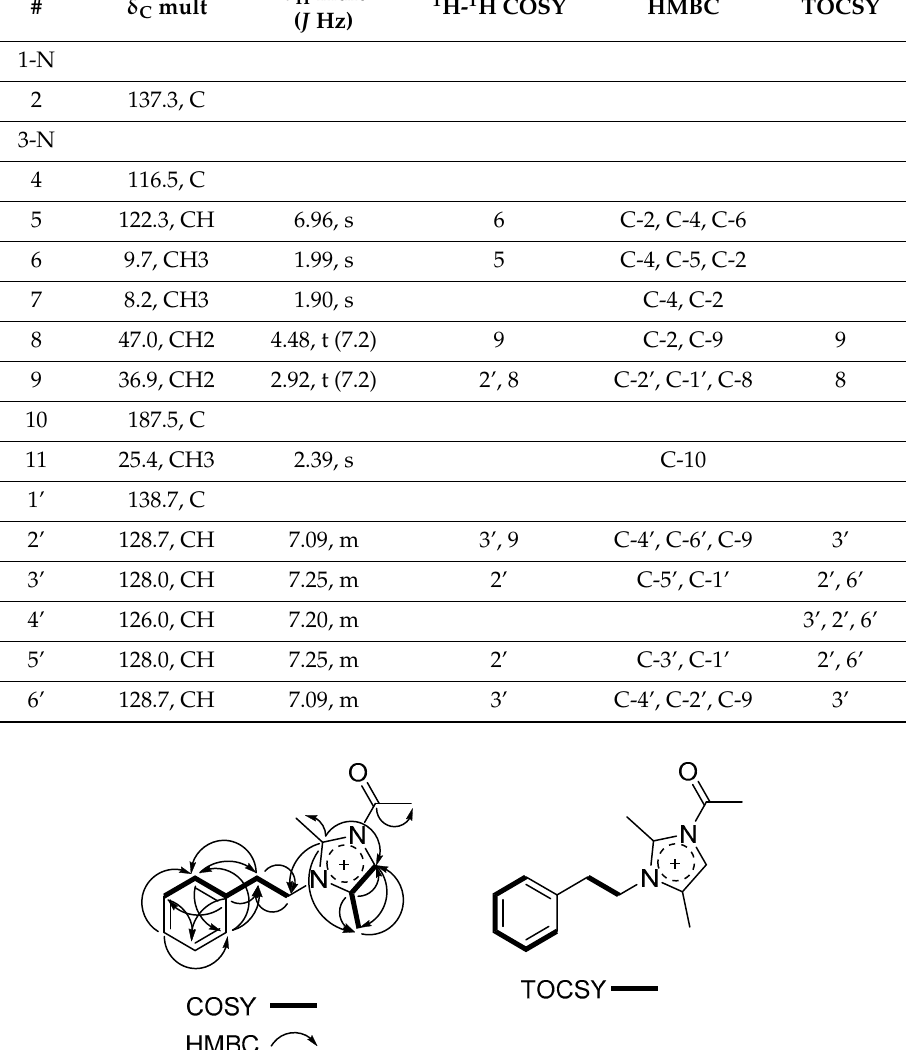
Table 1. 1D and 2D-NMR spectroscopic data for compound ( 1 ) in CD 3 OD, in ppm.